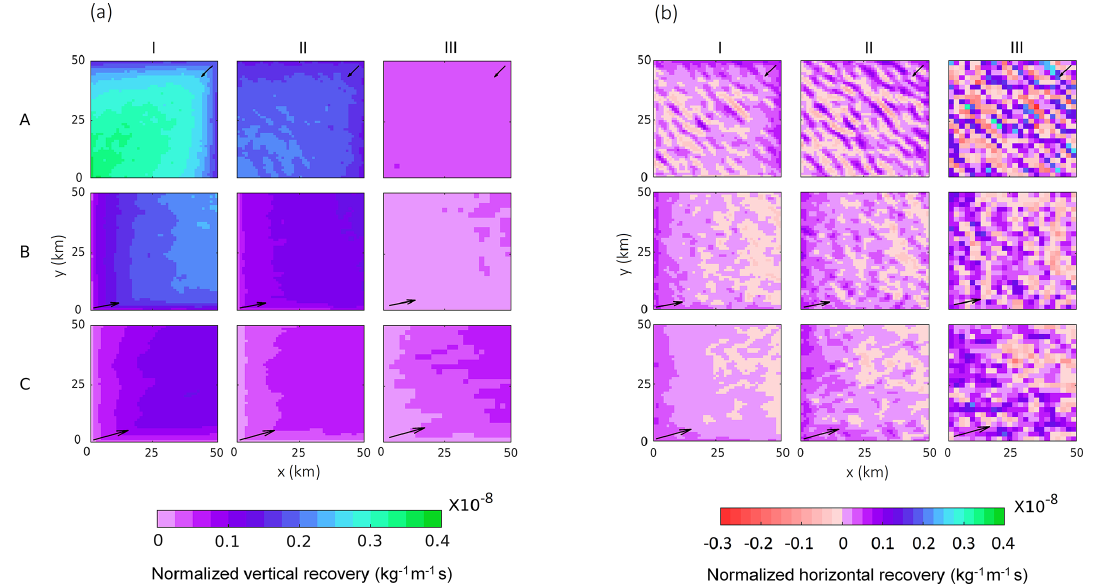
Figure 6. (a) Vertical recovery (normalized by power) and (b) horizontal recovery (normalized by power) for case (A) January, (B) June, and (C) July with (I) 0.5km, (II) 1km, and (III) 2km turbine spacings over the wind farms. Black arrows (scaled to the magnitude of averaged wind speed) show the prominent wind direction from the CTRL case.